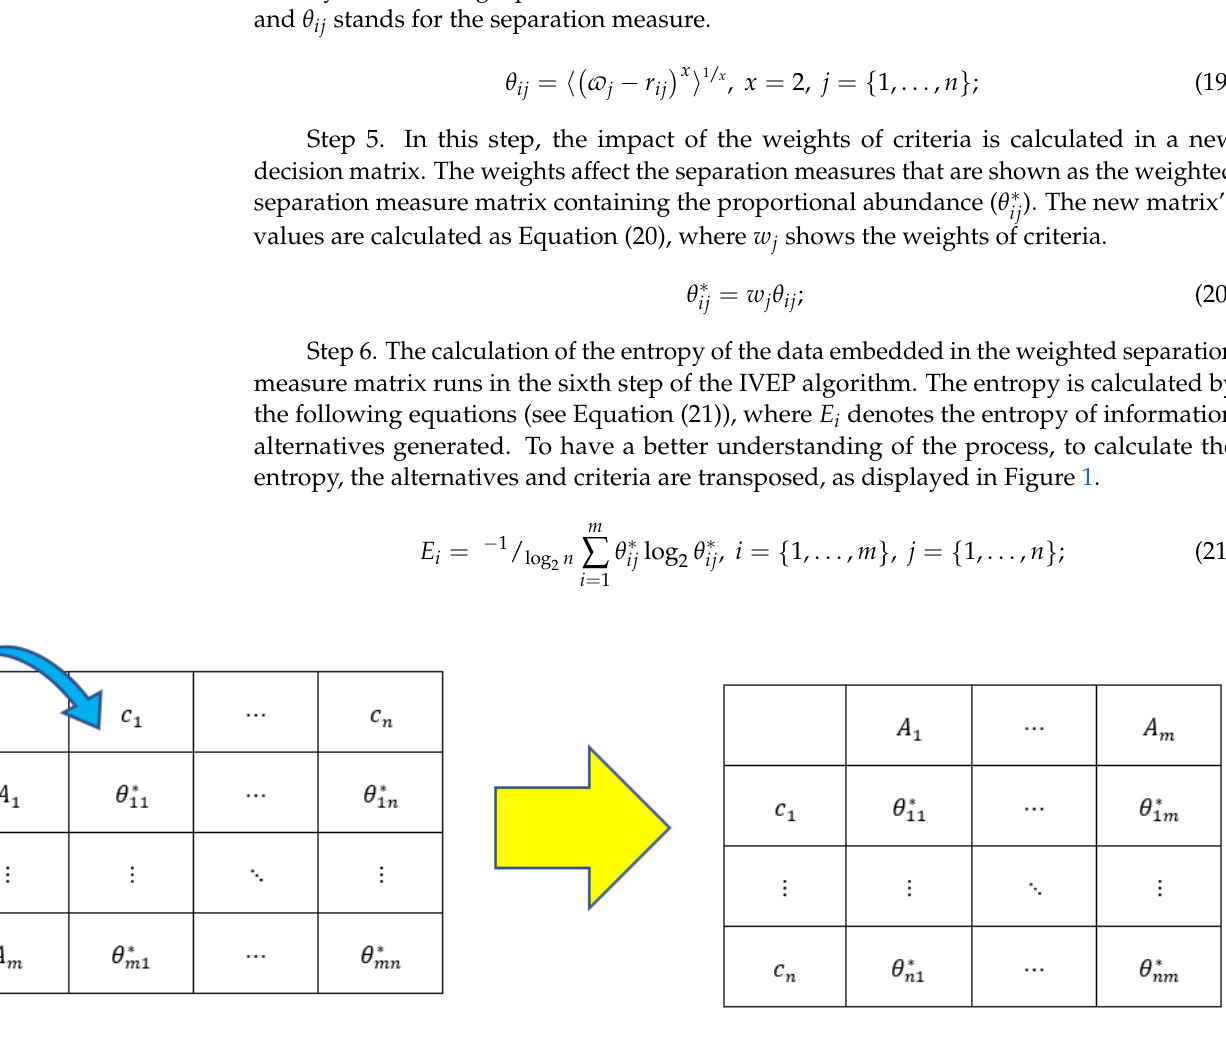
Figure 1. Transposing the weighted separation measure